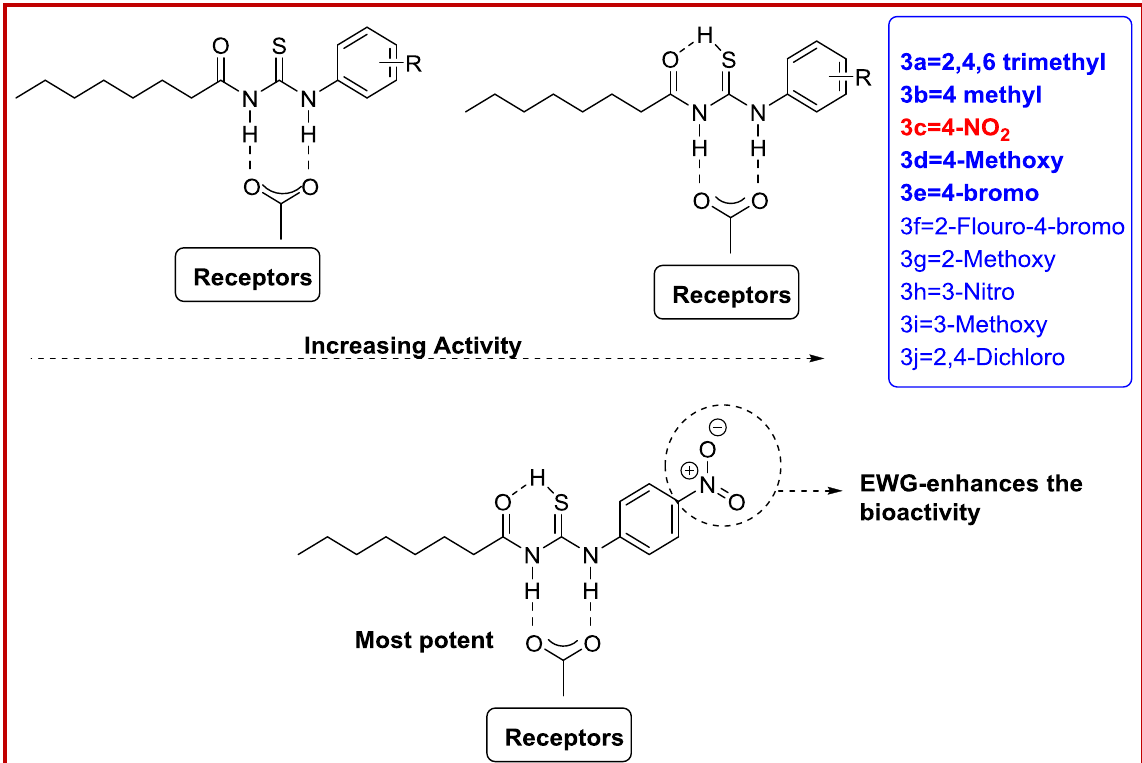
Figure 1: SAR relationship of series of 1-octanoyl-3-aroyl rubrum and Cryptococcus neoformans . Compounds ( 3a-i ) showed adequate activity.